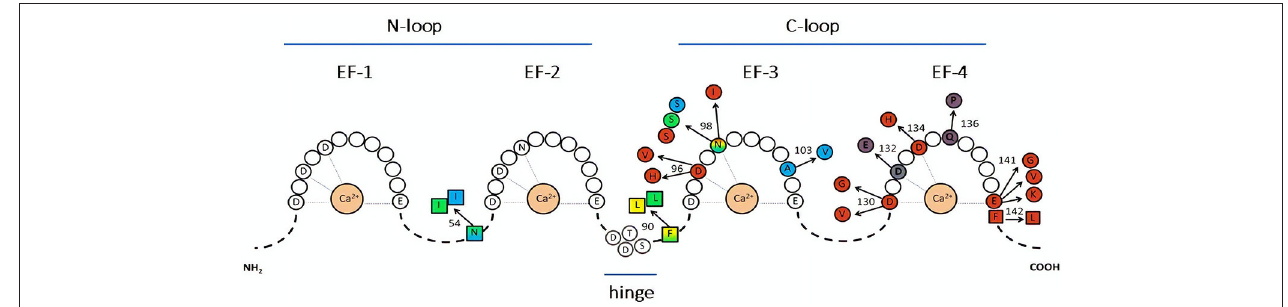
FIGURE 1 | Representation of CaM sequence and relative disease-associated mutations. The letters identify amino acids directly involved in Ca 2 + binding (within the EF-hands), or in the hinge region. Color-substituted amino acids represent mutations in the EF-hands (circles) or in the linkers (squares); colors correspond to the associated phenotype: catecholaminergic polymorphic ventricular tachycardia (CPVT, light blue), long QT syndrome (LQTS, red), idiopathic ventricular fibrillation (IVF, yellow), other unexplained sudden death (green). LQTS/CPVT overlap mutations are shown in shaded color. Modified from Crotti and Kotta,